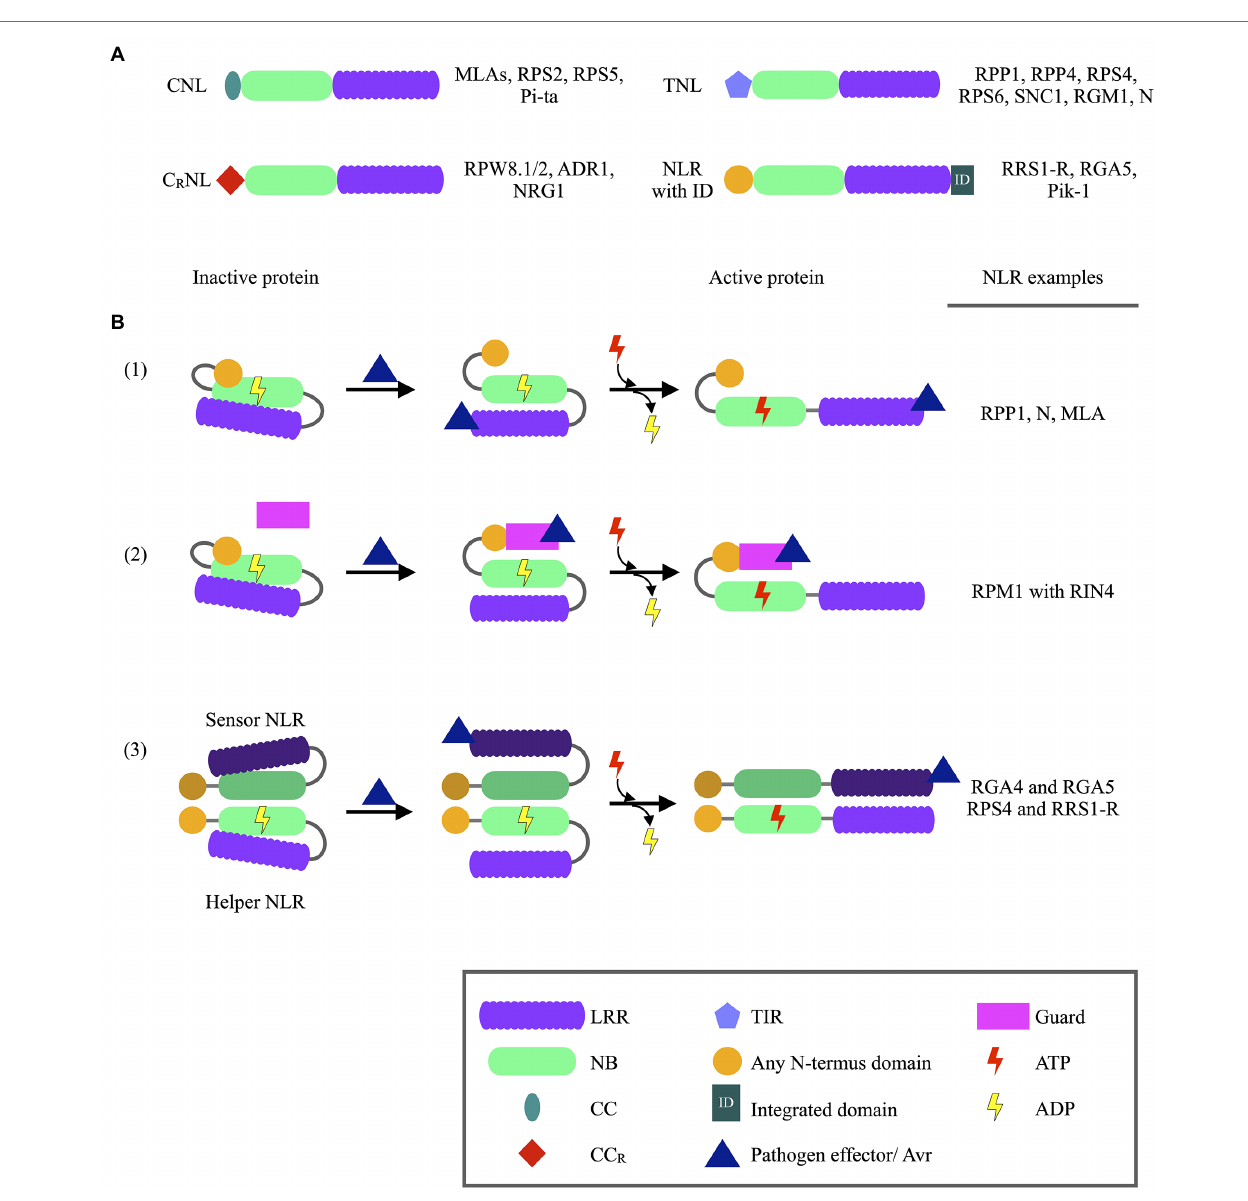
FIGURE 1 | Schematic representation of NLR protein domains and NLR activation, together with NLR protein examples. (A) Different structures of NLR proteins identified in plants, with NLR protein examples listed on the right of each schematic. (B) Models of Nucleotide binding-Leucine rich repeat (NLR) protein recognition of pathogen Avirulence (Avr) proteins. (1) Direct recognition of pathogen Avr protein through binding to LRR domains of NLR proteins. Avr recognition is followed by the exchange of ADP with ATP at the Nucleotide binding (NB) domain, which activates the protein and downstream immune responses. (2) Pathogen Avr proteins may bind to guard proteins which are under the surveillance of NLR proteins. Once Avr binding is recognized the NLR protein is activated through the binding of ATP, ultimately leading to immune response activation. (3) Avr recognition by NLR dimer pairs occurs when an Avr proteins binds to a sensor NLR. Structural changes of the sensor NLR induced by the Avr activates a helper NLR, subsequently leading to immune response activation. The binding of ATP to the sensor NLR is not required for NLR function (ADP—Adenosine diphosphate; ATP—Adenosine triphosphate; CC—Coiled coil; CC R —Coiled coil domain with integrated RPW8 domain; LRR—Leucine rich repeat; NB—Nucleotide binding; TIR—Toll/interleukin-1